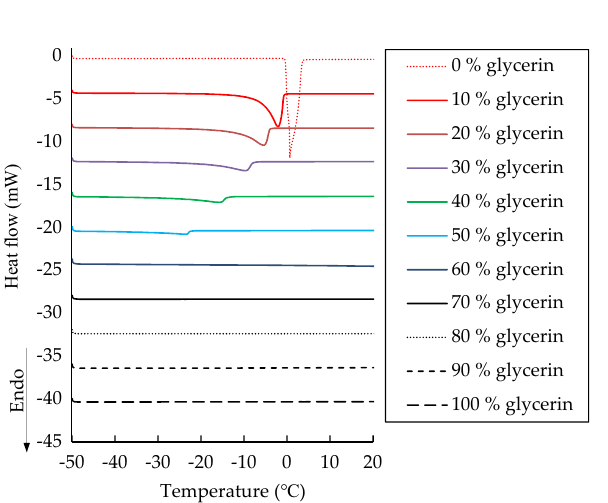
Figure 5. Heating curves of DSC thermograms at a 1 °C/min scanning rate for glycerin solutions of various